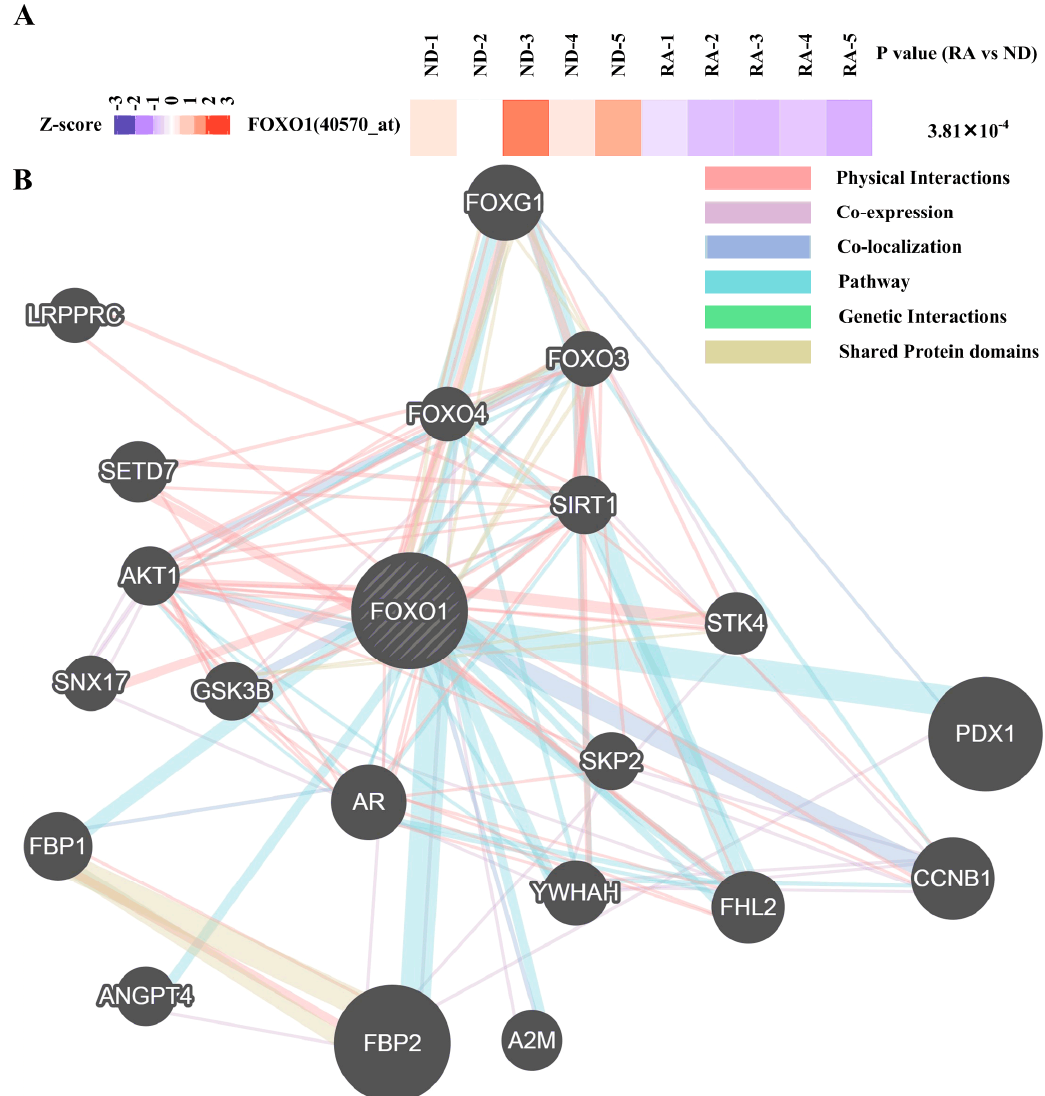
Figure 4. Expression and gene interactions of FOXO. ( A ) Heatmap showing the scaled expression of FOXO1 in rheumatoid arthritis (RA) synovial fibroblasts and normal donor (ND) synovial fibroblasts as well as P values in GSE1919 with corresponding probe identification shown in parentheses. ( B ) Gene interaction of FOXO1 with other proteins visualized by Gene Multiple Association Network Integration Algorithm (GeneMANIA) was shown.